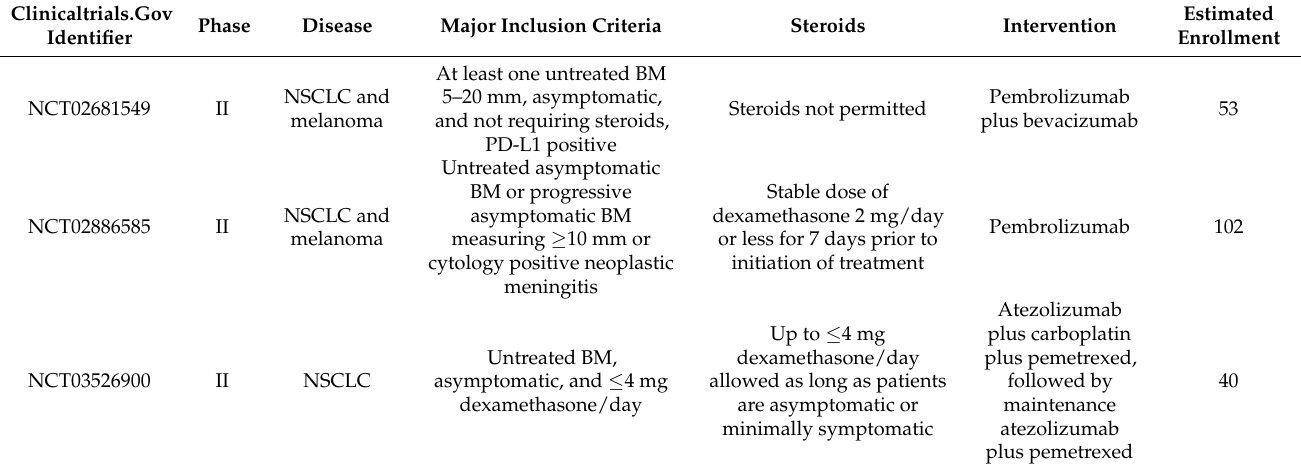
Table 2. Ongoing clinical trials with immune checkpoint inhibitors in patients with untreated brain metastases. Clinicaltrials.Gov